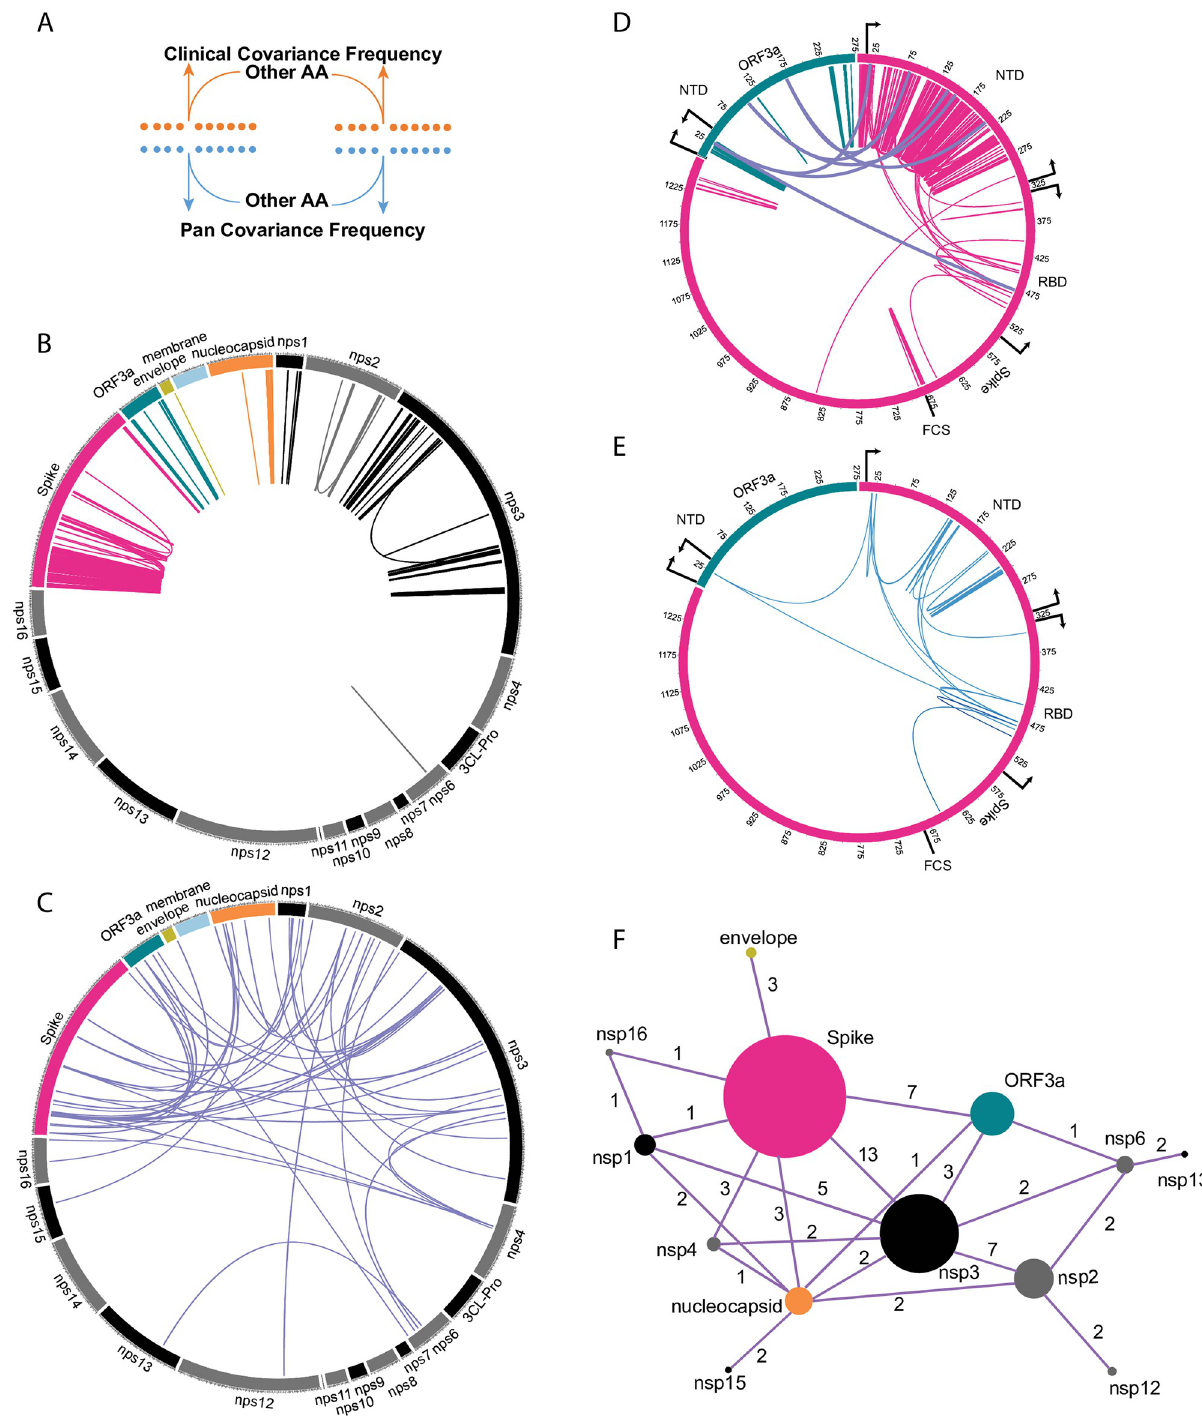
Fig 5. Mapping covariant pairs common to both clinical and pan analyses. (A) Diagram showing the concept of conserved residue pair. (B) Distribution of intra-gene covariant pairs. Links are colored by the gene. (C) Distribution of inter-gene covariant pairs. (D) Distribution of Spike and ORF3a inter-and intra-gene covariant pairs. Domains and boundaries of ORF3a (NTD) and Spike (NTD, RBD, and FCS) are shown. (E) Distribution of Spike and ORF3a covariant pairs from (D) that are also present in dominant circulating variants. (F) Network graph showing the number of covariant residues represented in each gene (size of circle) and the occurrence with the number of inter-gene covariant residues between each gene (value indicated for each linkage).